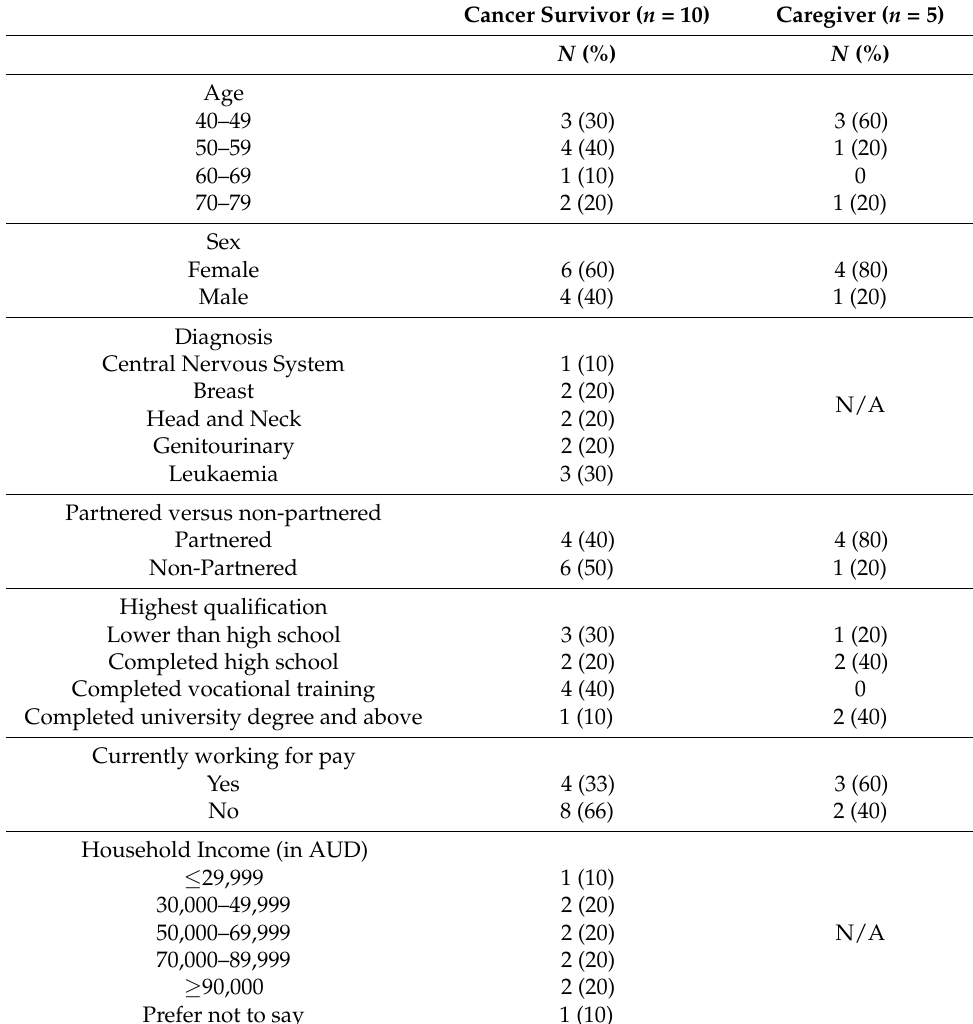
Table 1. Characteristics of the cancer survivor and caregiver